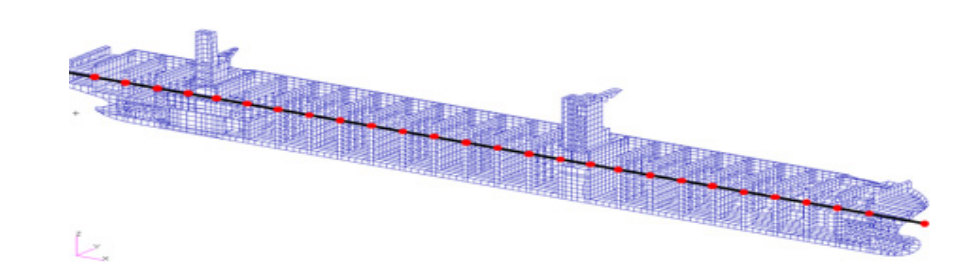
Figure 3. An example of a 1D beam model from a 3D global model.